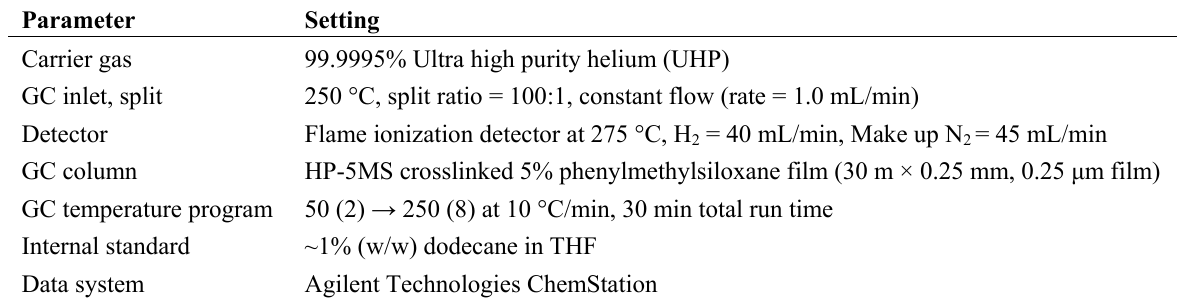
Table 3. GC-FID experimental parameters.